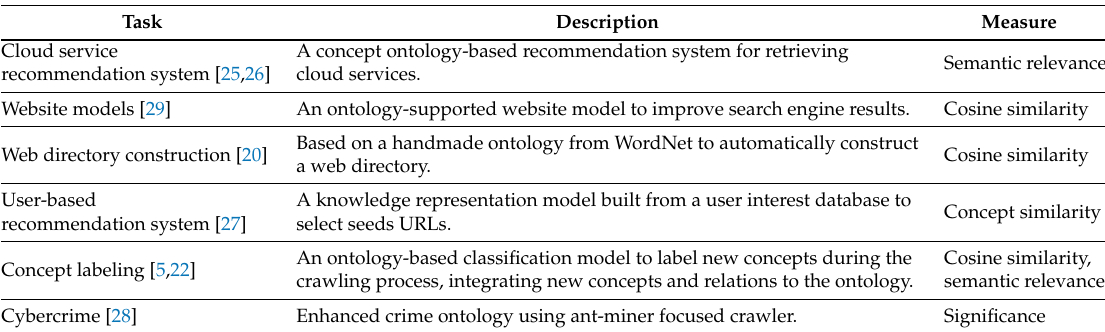
Table 1. Representative ontology-based